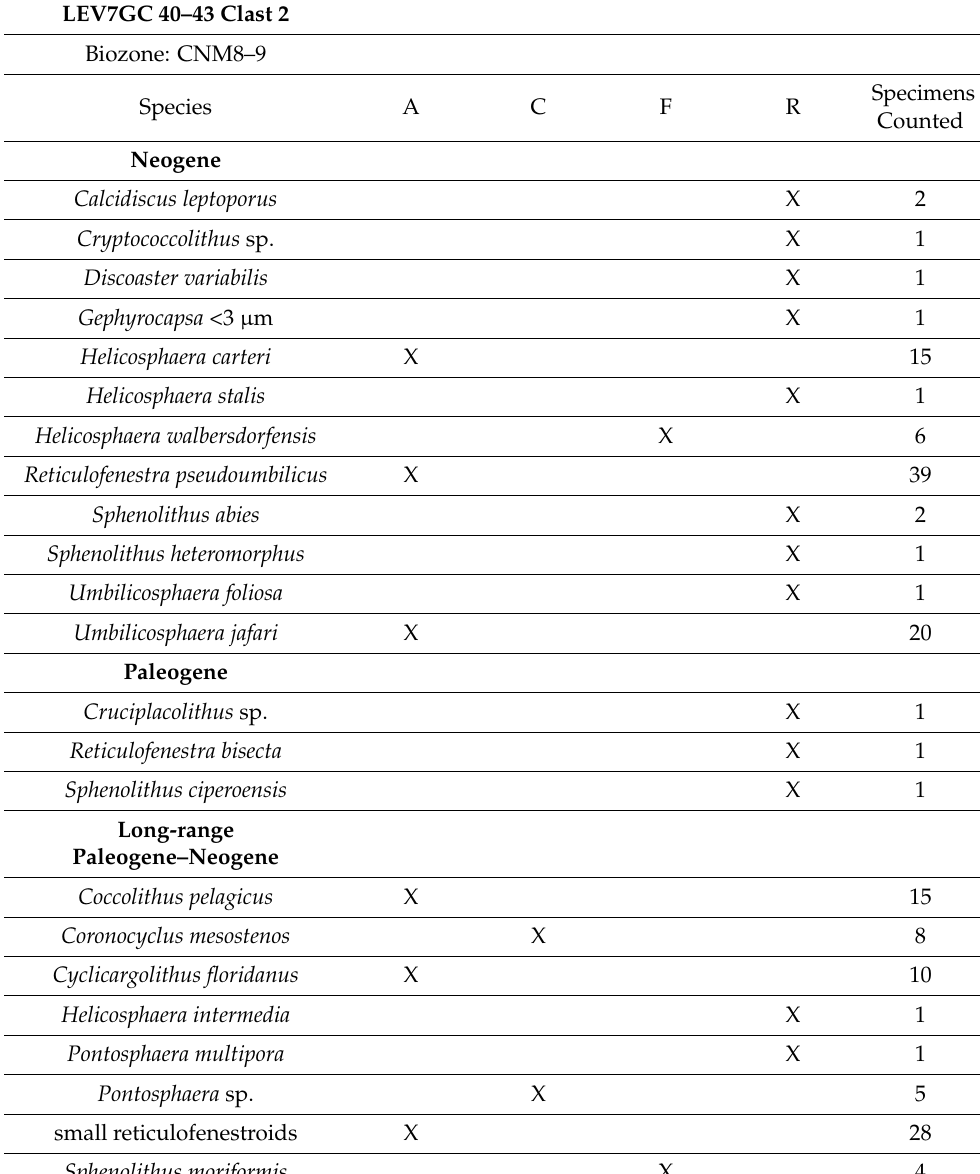
Table A32. Milano MV.